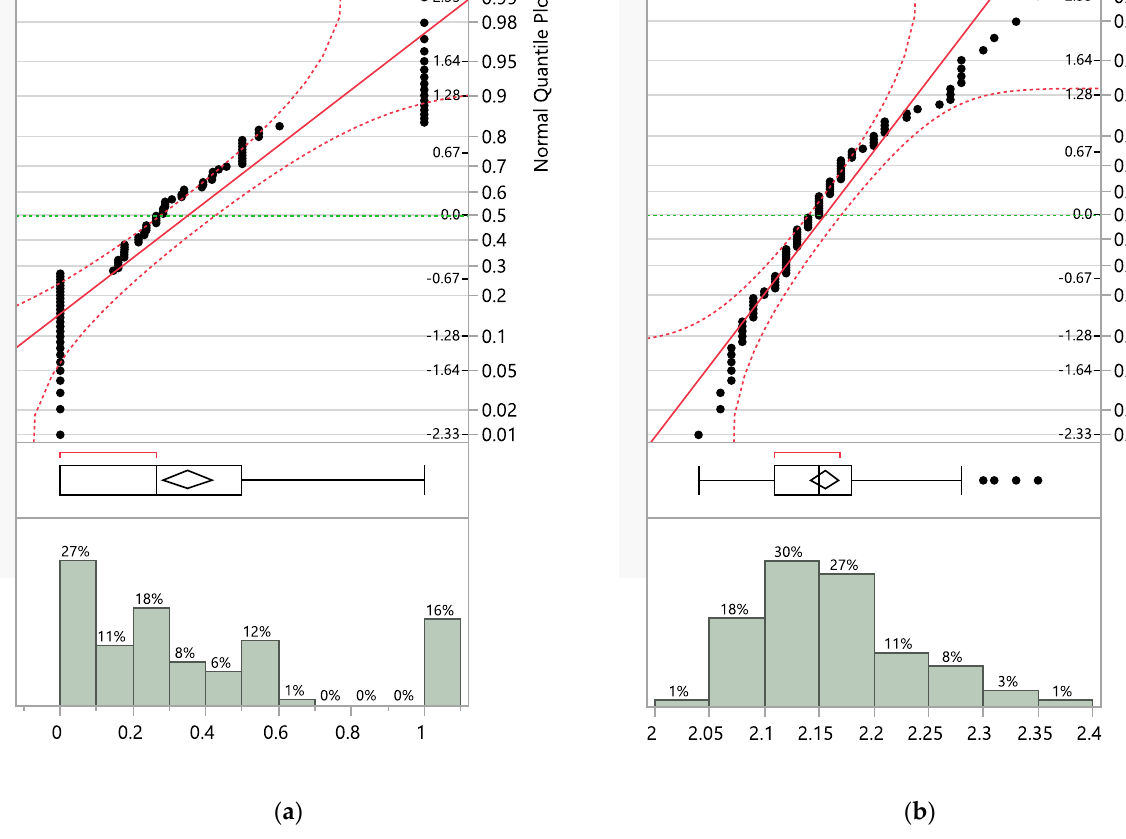
Figure 8. Distribution of: ( a ) r parameter; and ( b ) fractal dimension Df . The y-axis in range zero to one shows the empirical cumulative probability for each value, and the second y-axis shows the normal quantile scale. The dashed red line shows the Lilliefors confidence bounds [47], while the x-axis shows the column values. The most, i.e., 27% of all samples, were specimens after pure bending ( r = 0). On the other hand, the most common range of fractal dimension values was Df = 2.10–2.15 and amounted to 30% of the population.